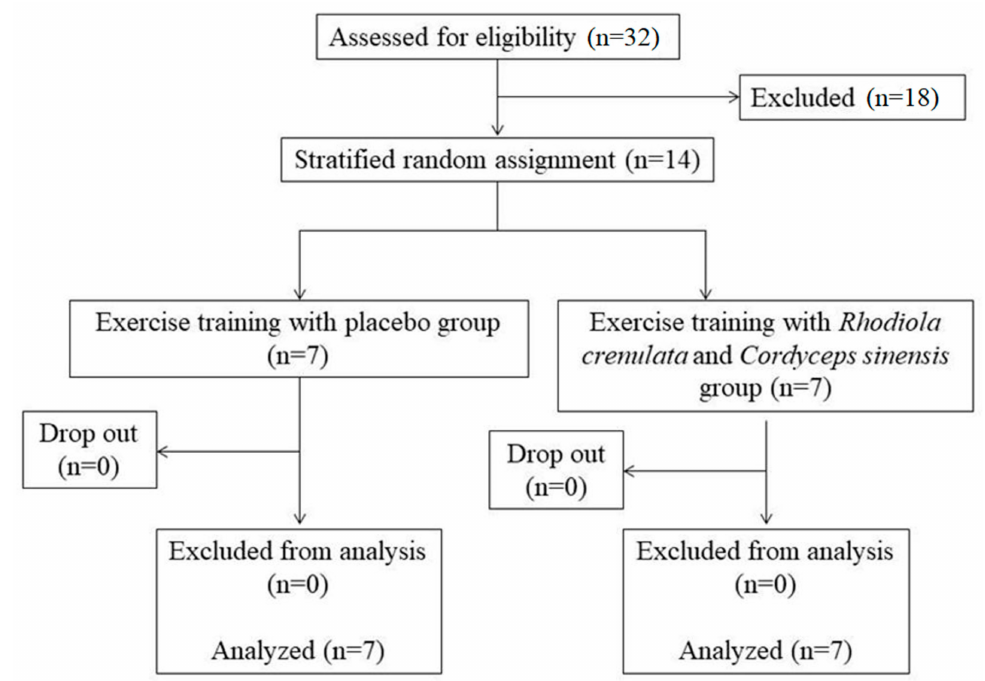
Figure 1. Flow chart of the